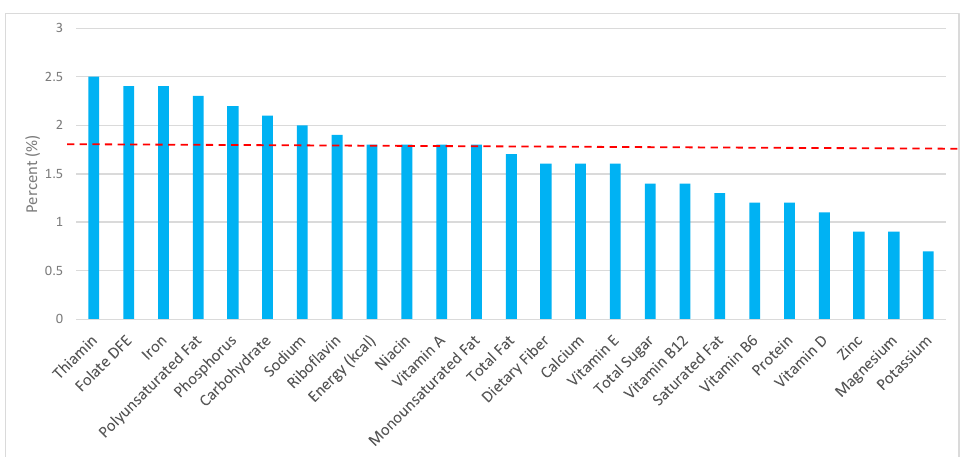
Figure 8. Quick breads and bread products as sources of energy and nutrients using NHANES 2009–2012, for adult females. Data are for adult females aged ≥ 19 years of age ( n = 5349), Day 1 intakes; dashed red line represents the percentage of energy provided and nutrients that surpass energy (kcal) contribution. Thus, nutrients above the dashed red line show the food category provides a greater percentage in the diet to showcase meaningful nutrient density in the diet per day.